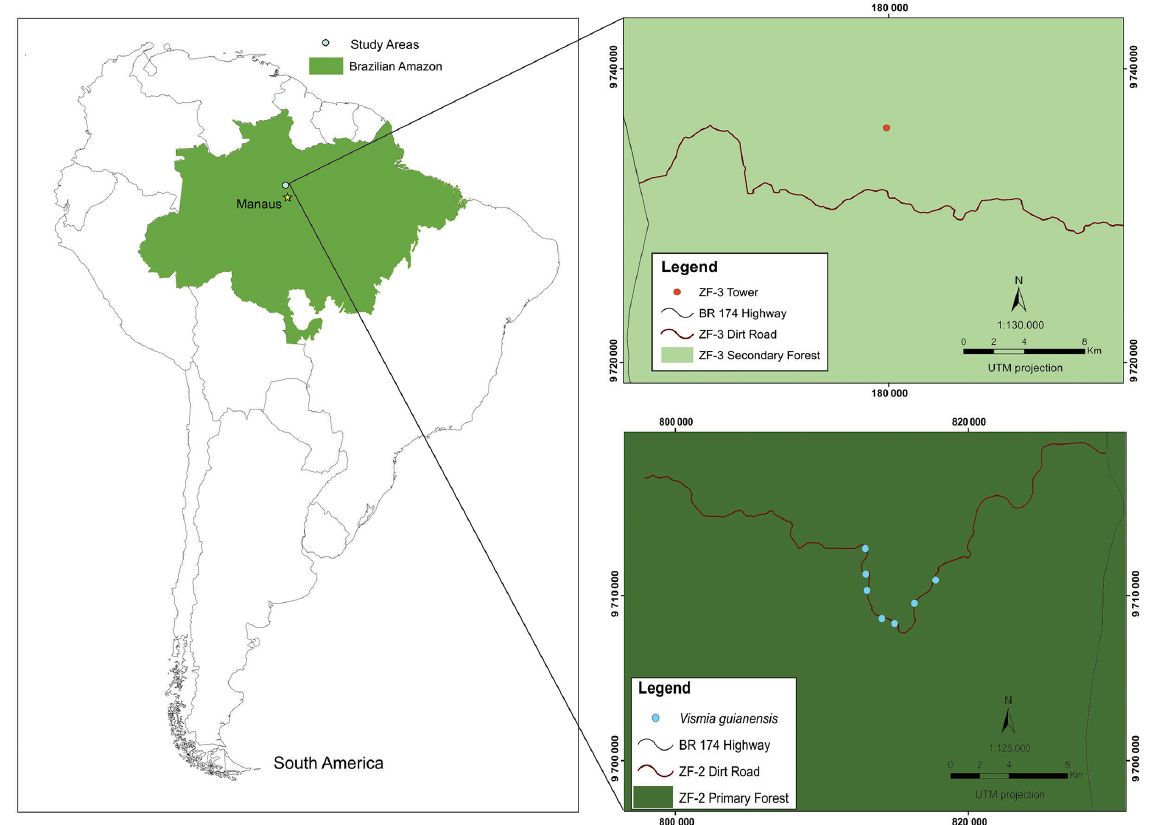
Figure 1. Location of the primary forest in the Reserva Biológica do Cuieiras (ZF2) and the secondary forest (ZF3) in the biological dynamics of forest fragments project near Manaus,